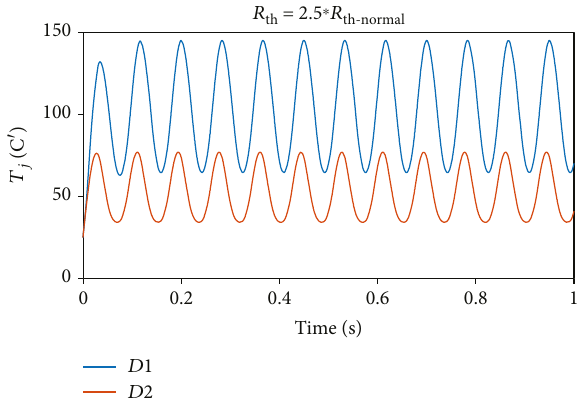
Figure 5: Power losses of parallel-connected power modules ( D 1 aged to 2 5 ∗ R th − normal ).